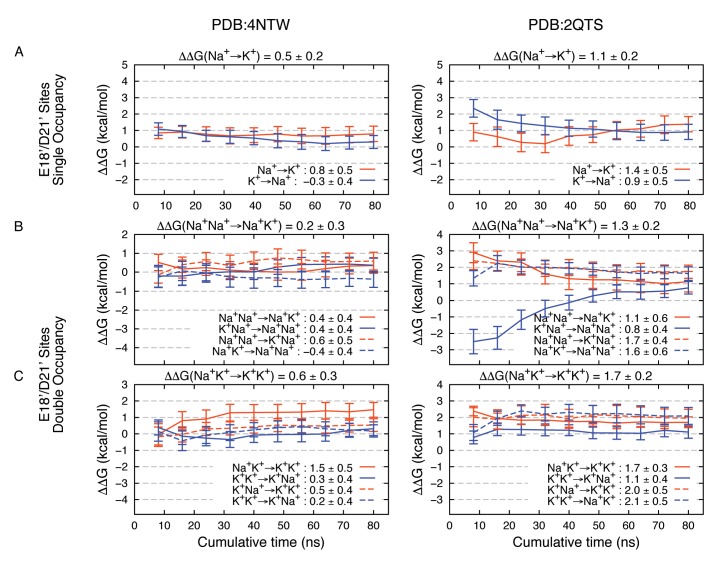
Estimated Na+→K+free energy perturbations for PDBs 4NTW (left graphs) and 2QTS (right graphs) with modified ion parameters.Results in panels A, B and C are as in Figure 2—figure supplement 1B,C and D, respectively, but with change in ion-carboxylate parameters to that of Marinelli et al. (2014), with rmin = 3.19 Å for Na+ and rmin = 3.52 Å for K+, instead of the usual mixing rules for CHARMM27*.